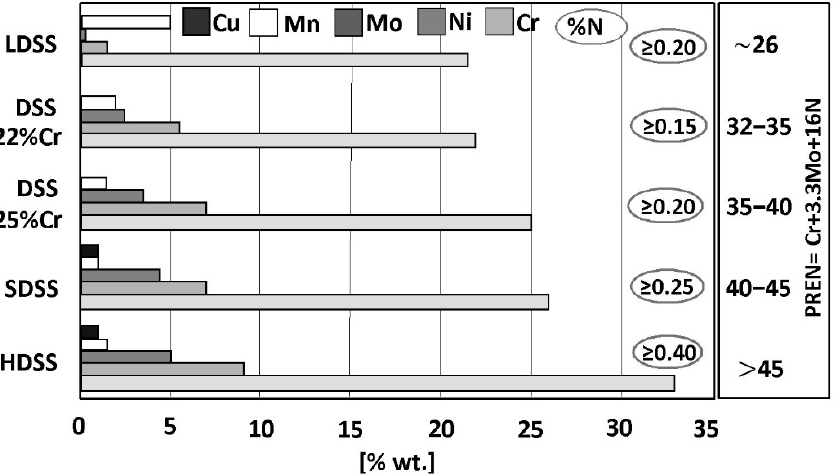
Figure 1. Chemical compositions and Pitting Resistance Equivalent Numbers (PREN) for various categories of duplex steels — according to [21].